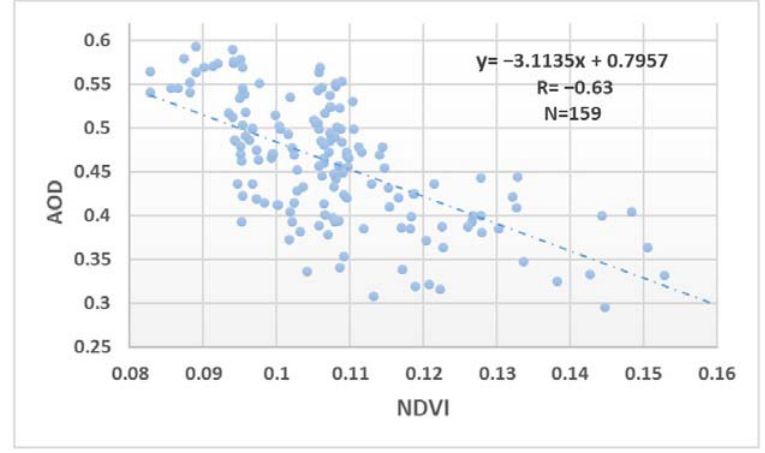
Figure 6. Correlation between AOD and NDVI for all dust hotspots between 2000 and 2019.